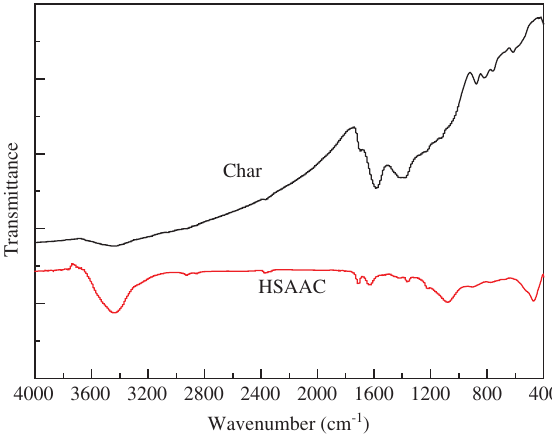
Figure 7: Fourier transform infrared (FTIR) spectra of char and high surface area activated carbon (HSAAC) from Eupatorium adenophorum